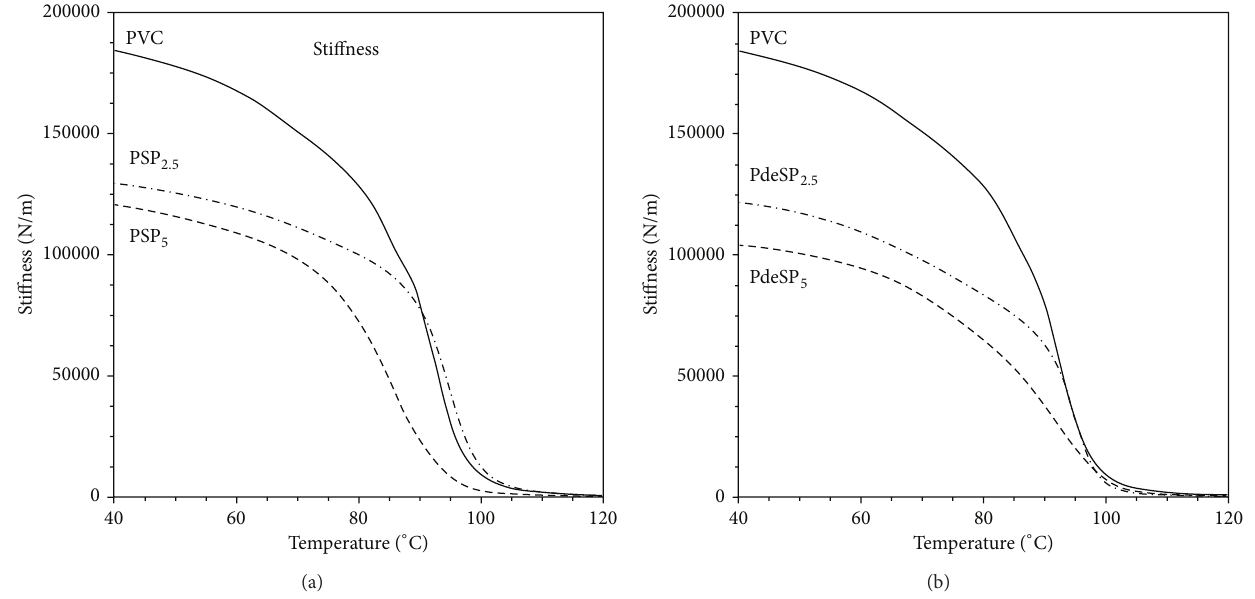
Figure 4: Temperature variation of film’s stiffness for (a) PVC, PSP 2.5 , and PSP 5 and (b) PVC, PdeSP 2.5 , and PdeSP 5 .